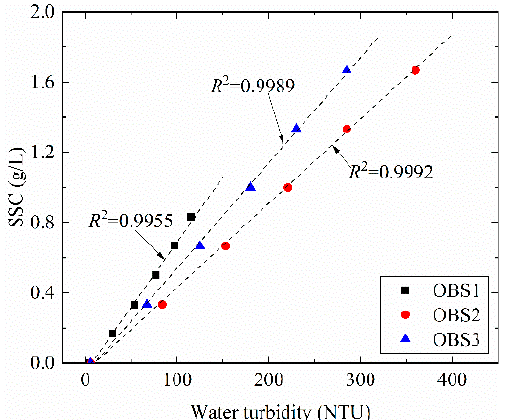
Figure 7. The correlation of the turbidity recorded by the OBS sensor against the suspended sediment concentration.